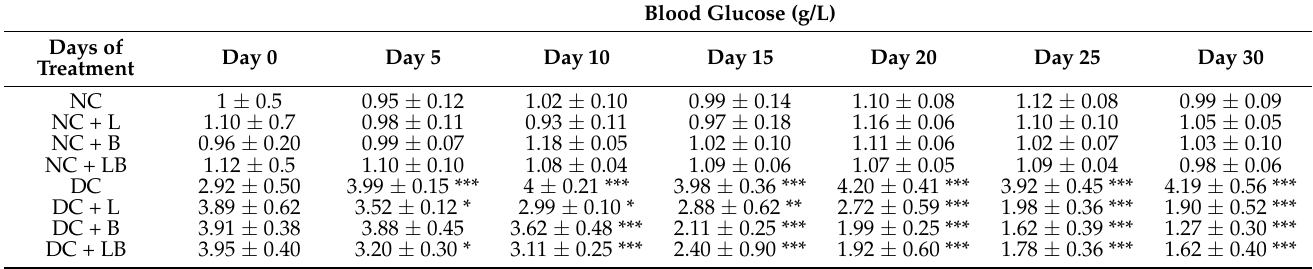
Table 3. Blood sugar levels of normal and diabetic rats during the experimental period (4 weeks). Blood Glucose